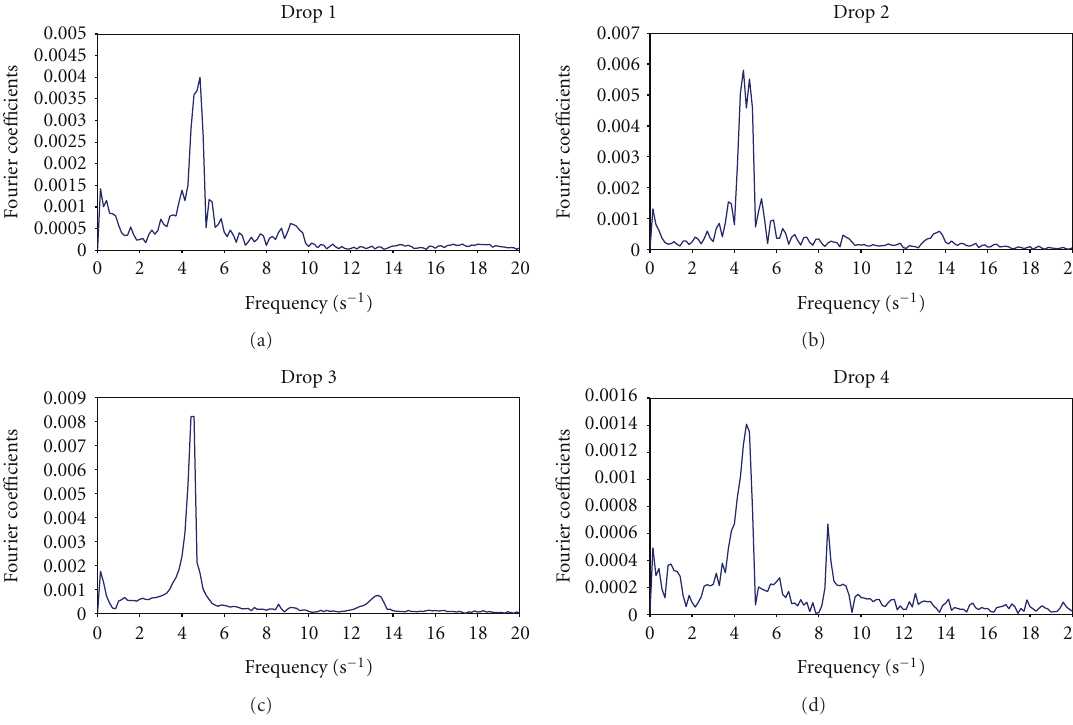
Figure 4: FFT absolute coe ffi cients relative to the c 2